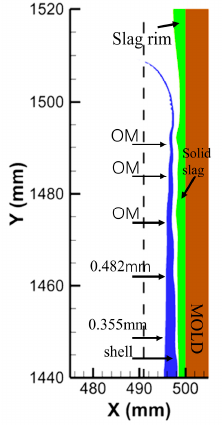
Figure 5. Predicted initial shell.